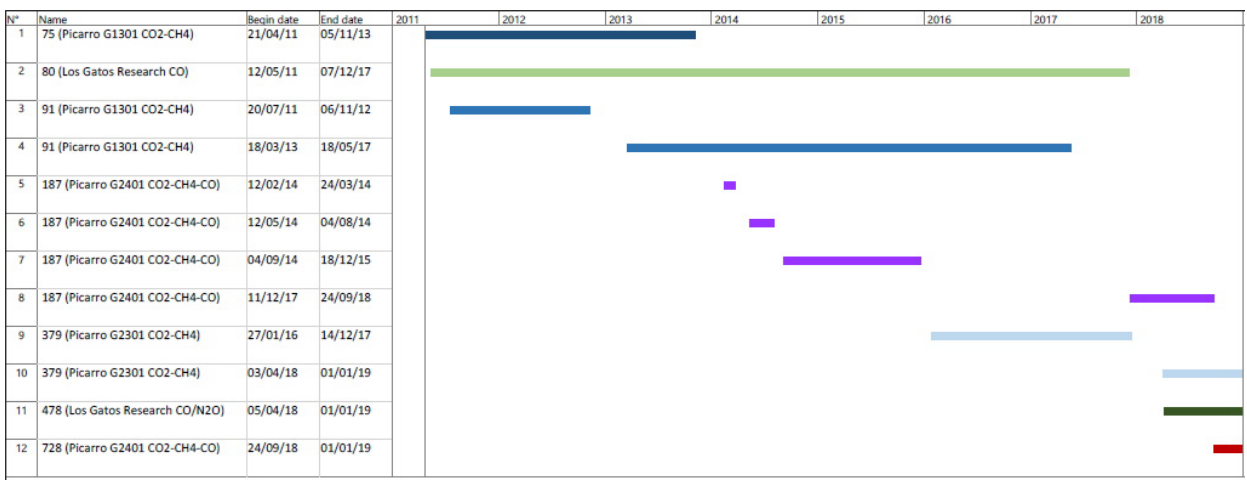
Figure 4. Time diagram showing the different GHG analysers in operation at the OPE station.